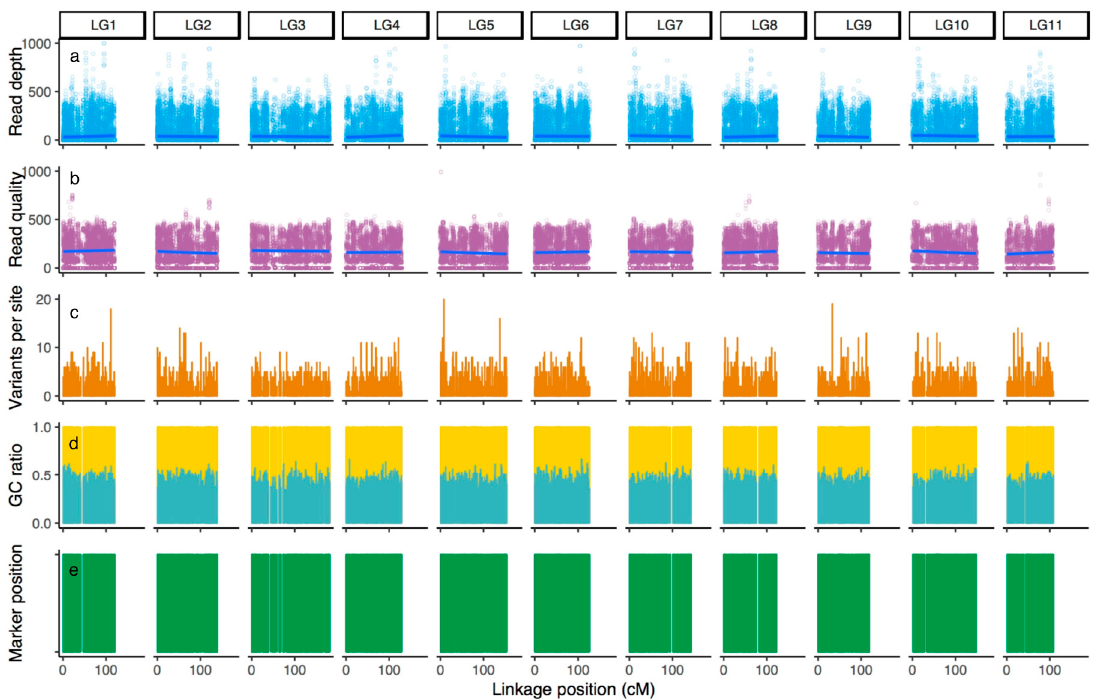
Figure 2. Parameters determined through genotyping for primary evaluation with the custom primer panel: ( a ) read depth; ( b ) read quality score; ( c ) number of variants per site; ( d ) GC ratio; and ( e ) marker position. The linkage positions of the amplicons on the linkage map in C. japonica published by Mishima et al. [36] are shown.